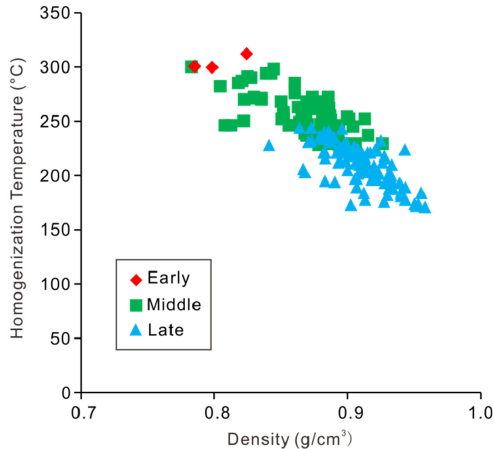
Figure 8. Temperature-density diagram for fluid inclusions from the Baiyinhan tungsten